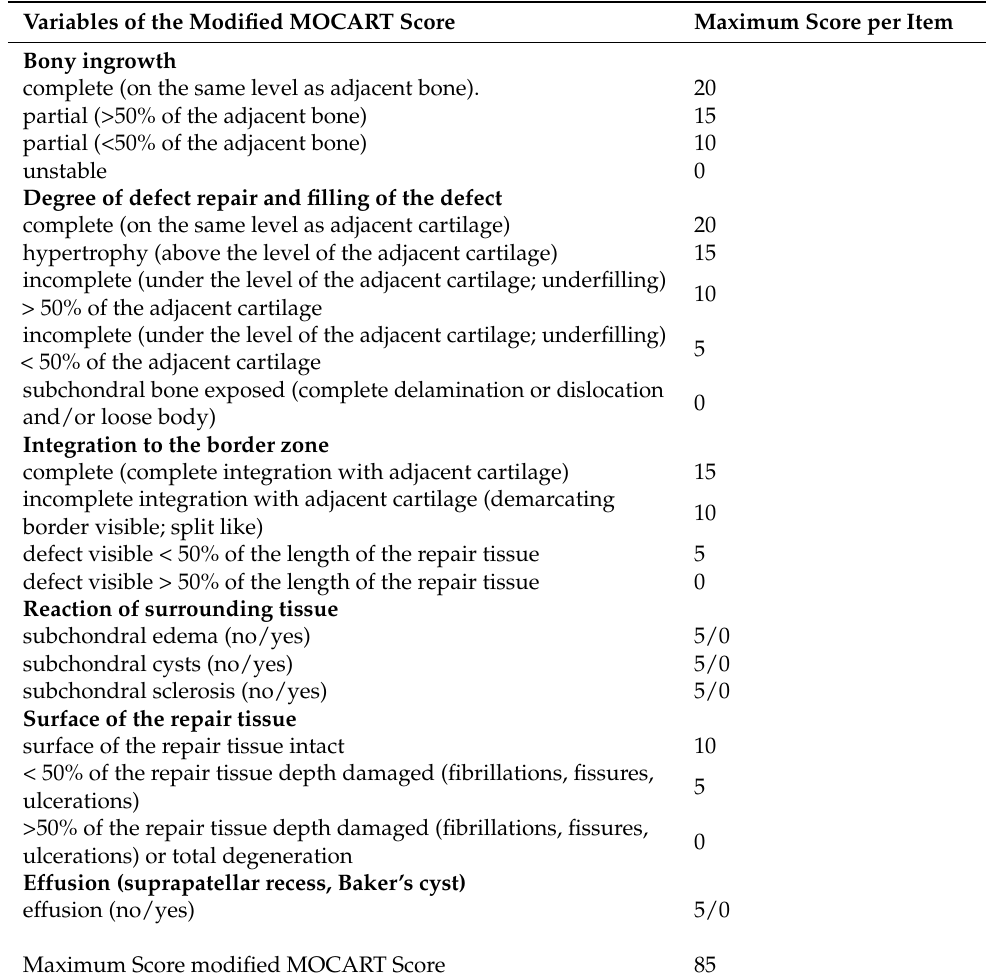
Table 2. Variables of the modified MOCART